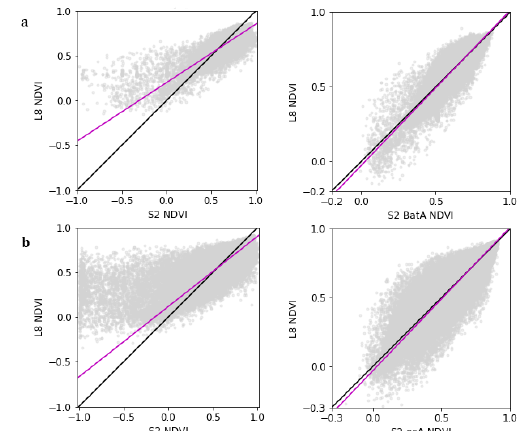
Figure A4. Comparison of NDVI values from Batagay (( a ), upper row) and Eastern Siberia (( b ), lower row). Left plots: NDVI calculated from observed surface reflectance values. Right plots: NDVI calculated from adjusted Sentinel-2 reflectance values. The solid black line is one-to-one, and the pink line is the ordinary least squares regression trend